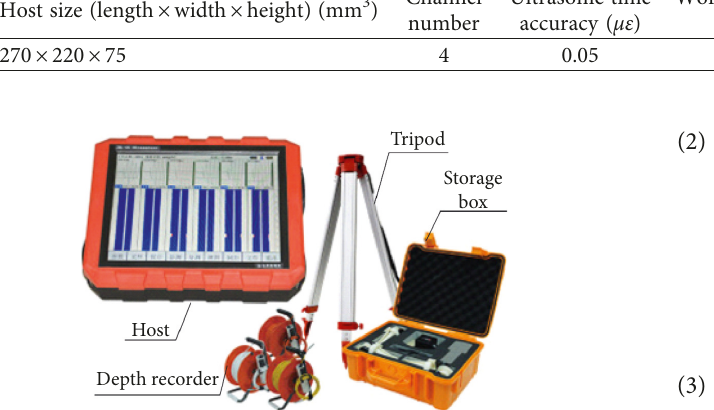
Figure 14: Mine ultrasonic